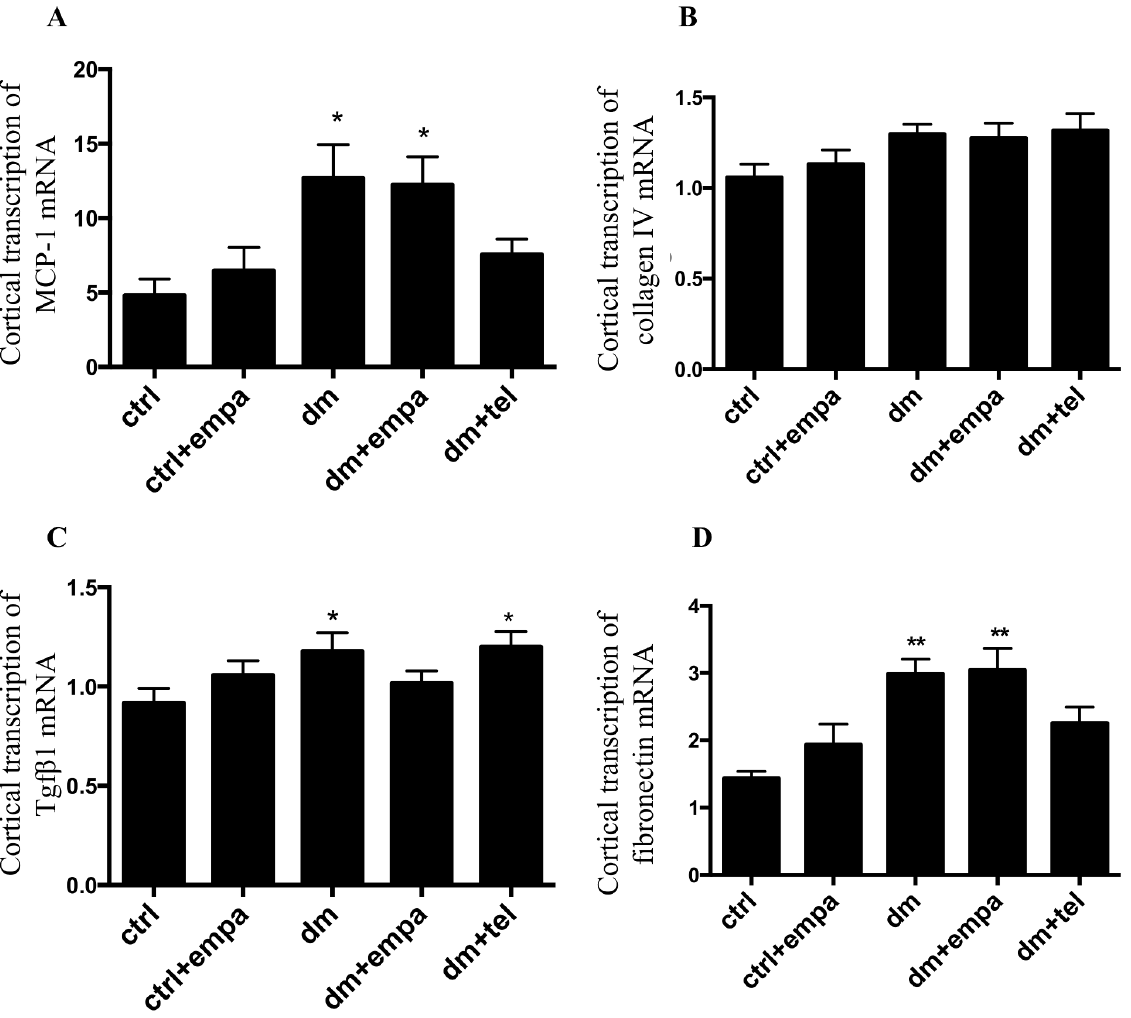
Figure 5. Diabetic mice showed increased renal cortical transcription of inflammatory and fibrotic cytokines, which was not improved by empagliflozin. Real time PCR results for Renal cortical transcription of A) MCP-1, B) Collagen 4, C) TGF b and D) Fibronectin relative to actin (Data are expressed as mean 6 SEM with *=P , 0.05 vs ctrl and **=P , 0.001 vs ctrl).